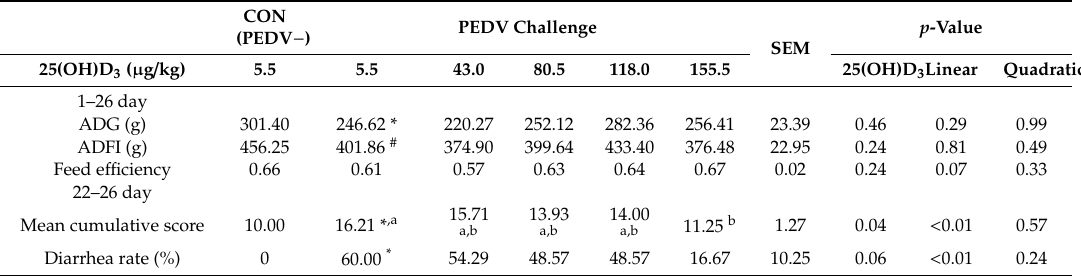
Table 3. Growth performance and diarrhea parameter of weaned piglets fed 25(OH)D 3 as indicated with porcine epidemic diarrhea virus (PEDV)